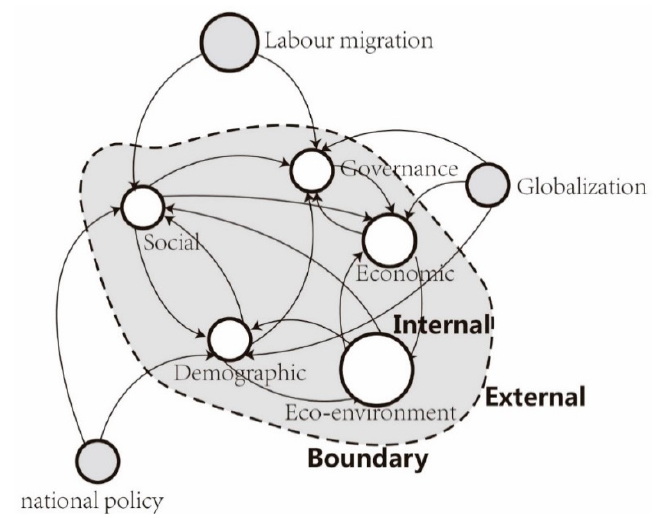
Figure 2. Illustration of external and internal influence on eco-environment in mega city-region. Source: Drawn by authors.